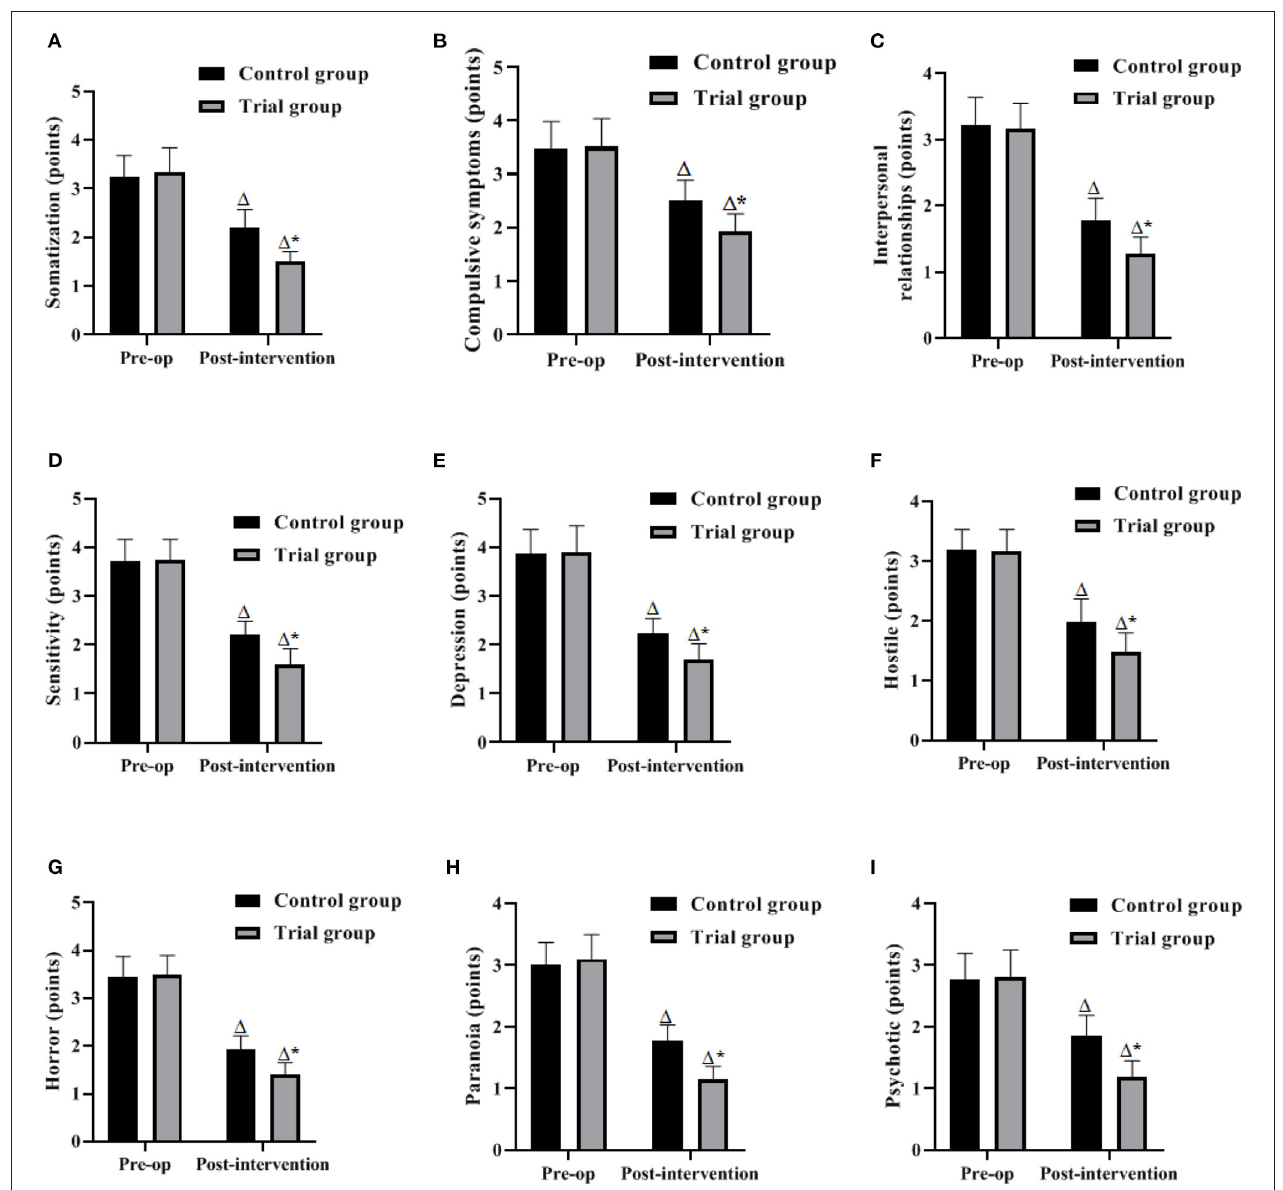
FIGURE 3 | Comparison of negative emotions between the 2 groups (Mean, SD). The contents in (A–I) are somatization, obsessive-compulsive symptoms, interpersonal, sensitivity, depression, hostility, phobia, paranoia, and psychoticism, respectively. Difference from the same group preoperatively 1 P < 0.05; difference between the two groups * P <